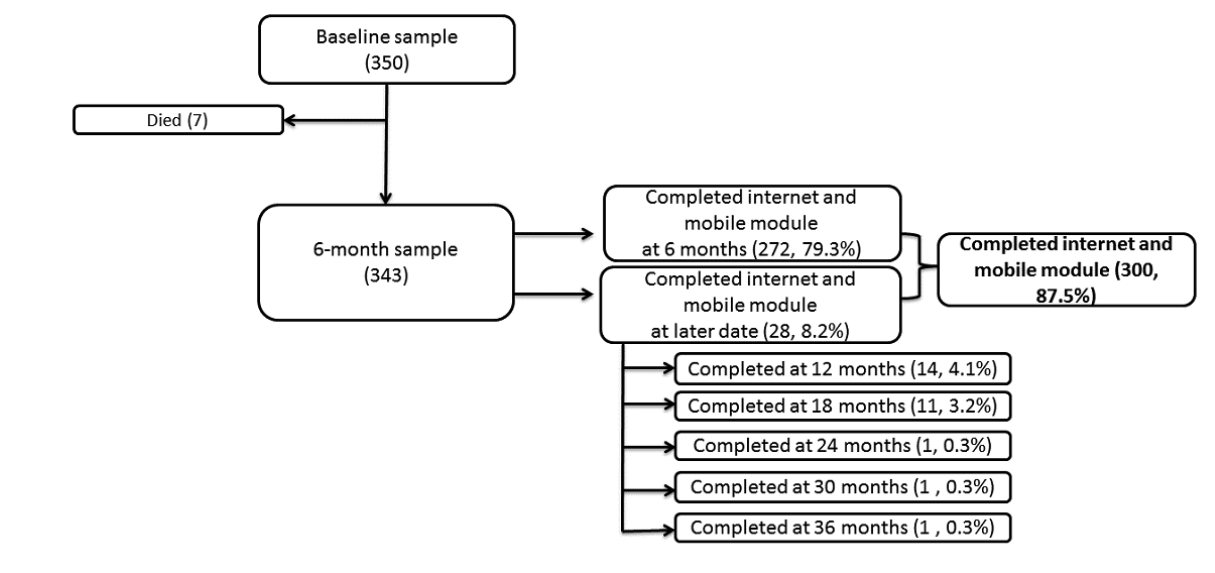
Figure 1. Recruitment